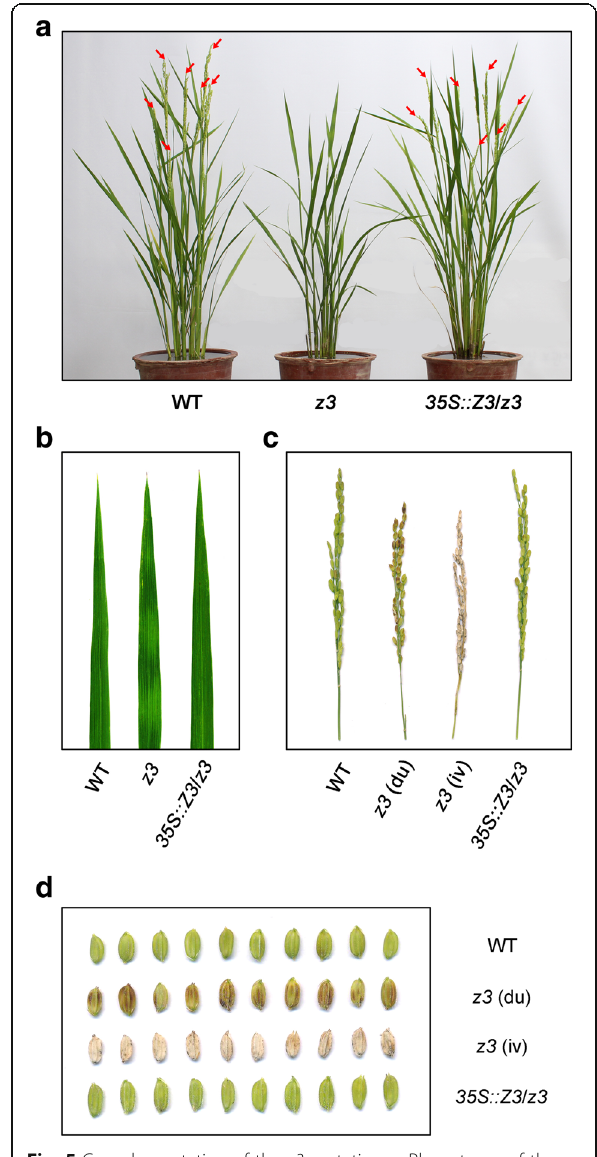
Fig. 5 Complementation of the z3 mutation. a Phenotypes of the WT, the z3 mutant, and the 35S::Z3 / z3 transgenic plant at 80 DAS grown under natural long day conditions. Leaf variegation and delayed flowering (Additional file 1: figure S1) of the z3 mutation were rescued by the transformation of 35S::Z3 construct. WT flowered around one month earlier than the days to heading data in Additional file 1: figure S1 because the seeds of the WT, the z3 mutant, and the 35S::Z3 / z3 transgenic plant in Fig. 5a were sown on June, not in April (Suwon, Korea, 37°N latitude). Arrows indicate the panicle. b Leaf phenotypes of the WT, the z3 mutant, and the 35S::Z3 / z3 transgenic plant at 80 DAS grown in the paddy field. c – d Panicle and grain phenotypes of 80-day-old WT, z3 mutant, and 35S::Z3 / z3 transgenic plants grown under natural long day conditions. z3 (du), dull-brown colored grain of the z3 mutant; z3 (iv), ivory colored grain of the z3